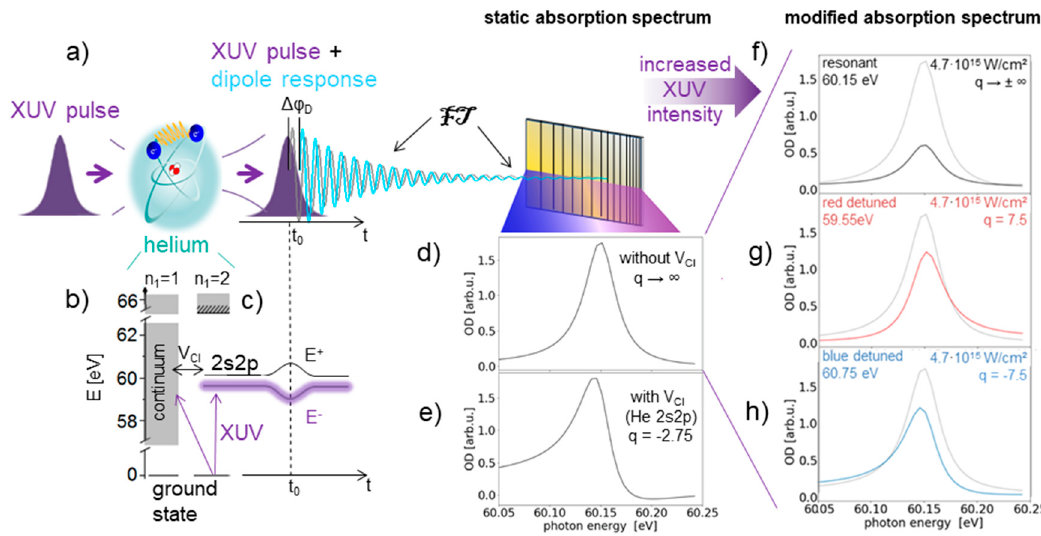
Figure 1. ( a ) the interaction of an ultrashort extreme-ultraviolet (XUV) pulse (violet) with an atom, e.g., helium, leads to the emission of a dipole response (blue) interfering with the driving XUV pulse. ( b ) simplified energy level scheme of helium. With a photon energy of 60.15 eV the helium atom can be either singly ionized or excited into a doubly excited state, which autoionizes due to its configuration interaction V CI with the ionization continuum. Corresponding absorption spectra are shown in ( d , e ). If the configuration interaction is disregarded, the absorption profile is Lorentzian ( d ), whereas the inclusion of the configuration interaction leads to a Fano absorption line shape ( e ). ( c ) dressed states are generated in the presence of an intense XUV pulse. The states’ energy separation increases with increasing XUV laser intensity and depends on the detuning [1,2], therefore their energy shift follows the Gaussian pulse envelope in time (compare to a), here illustrated for a red-detuned case. This leads to a temporal dipole phase shift ∆ ϕ D with respect to the weak-field response (grey in a) [8]. ( f )–( h ) manipulated absorption profiles of the two-level system (without configuration interaction) initiated by the strong coupling with an XUV pulse of di ff erent detunings. ( f ) the peak intensity of a resonant laser pulse is increased to 4.7 × 10 15 W/cm 2 leading to a decreased amplitude of the resonance, but leaving the line shape unchanged (q → ±∞ ). ( g , h ) the additional detuning of the laser pulse to central photon energies (cid:125) ω c of 59.55 eV or 60.75 eV, leads to modified now asymmetric absorption line shapes with a positive or negative q -parameter, respectively.